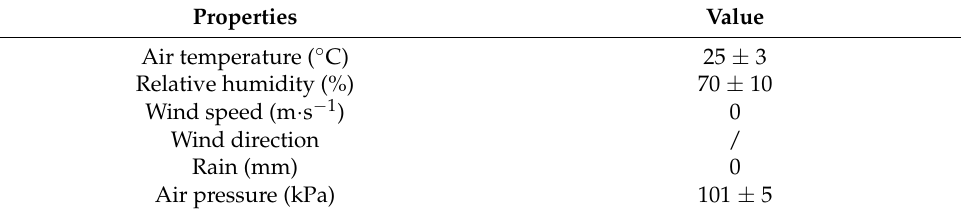
Table 3. Environment